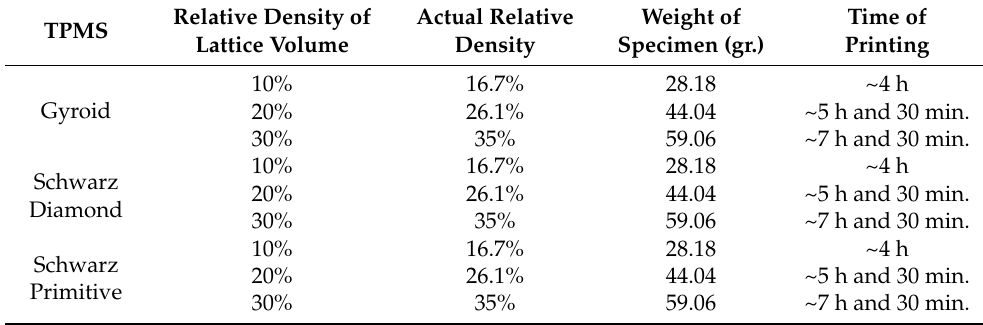
Figure 4. 3D-Printed TPMS specimens with different relative densities. Table 4. Structural Properties of 3D Printed Specimens.